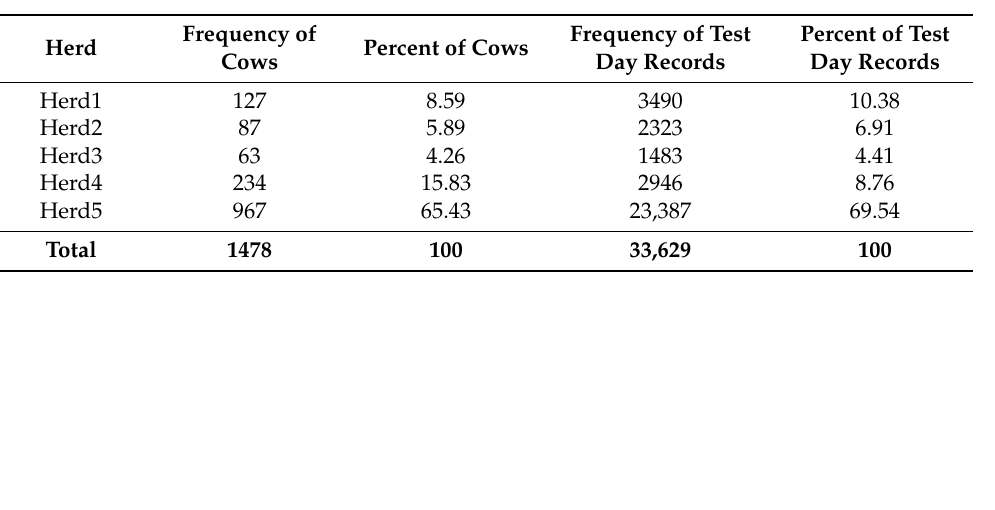
Table 1. The number of genotyped cows and the number of test day records by